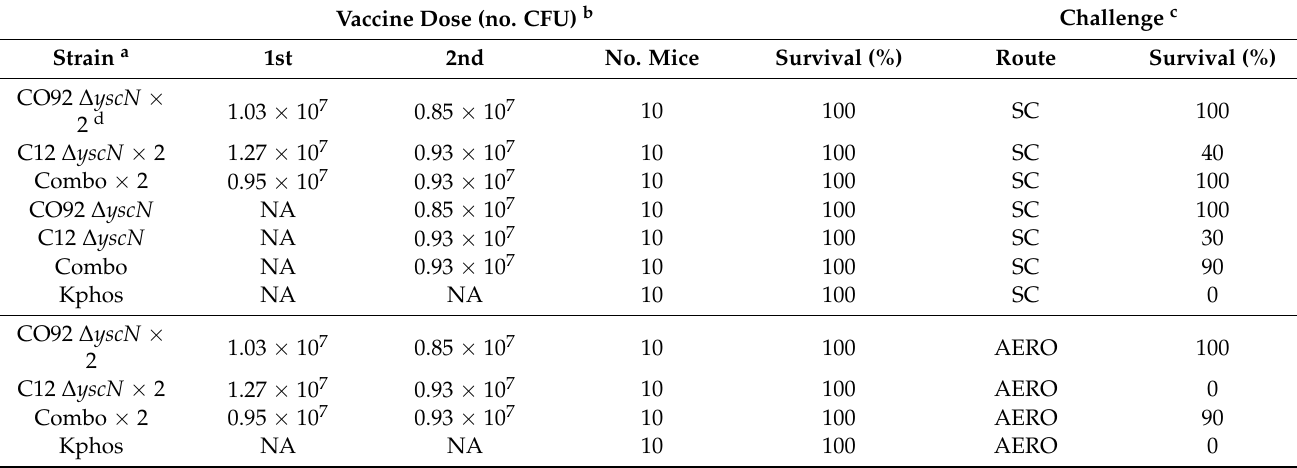
Table 6. Protection of BALB/c mice with live Y. pestis vaccine strains versus virulent challenge. Vaccine Dose (no. CFU) b Challenge